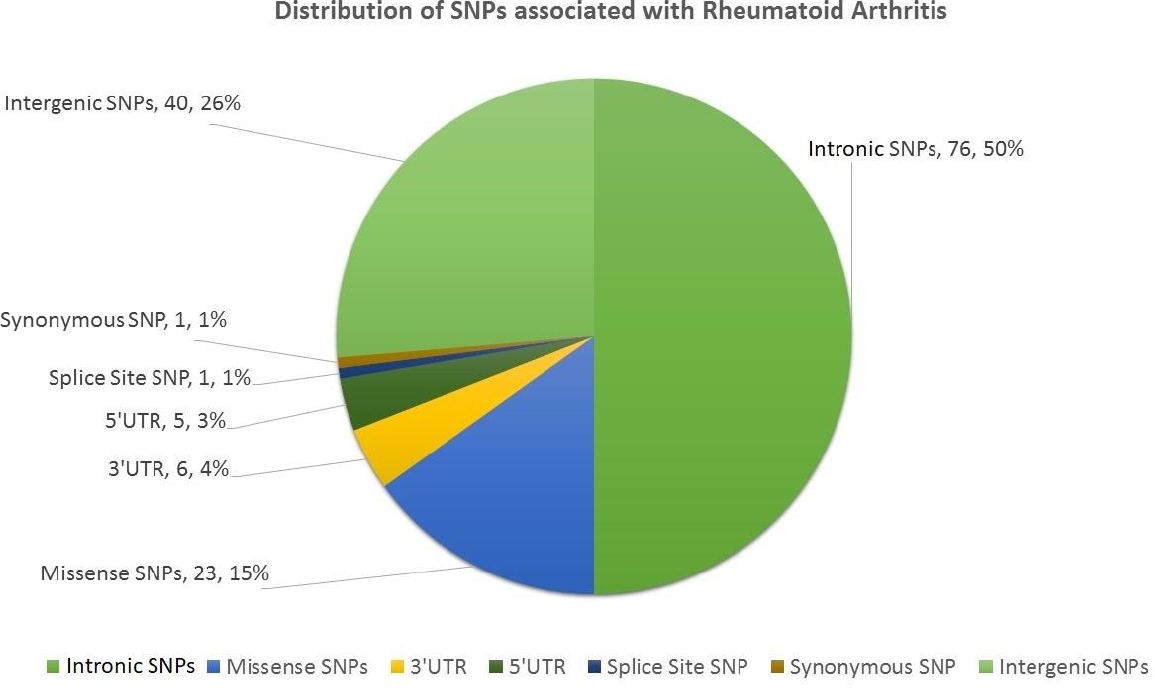
Figure 2. Distribution of SNPs associated with RA, represented in a pie chart. This figure was generated using Microsoft Excel 2016.